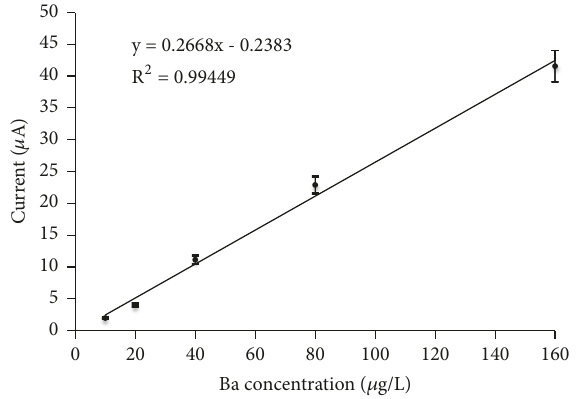
Figure 4: Linear range 10-160 𝜇 g/L (r 2 =0.994) for GCE, 0.02 M KCl electrolytewith5mg/LHg(0.0015MHNO 3 ),t dep =30sec,dp=-2500 mV, 100 mV/s; error bars were determined from standard deviation from 3 replicates of each concentration.